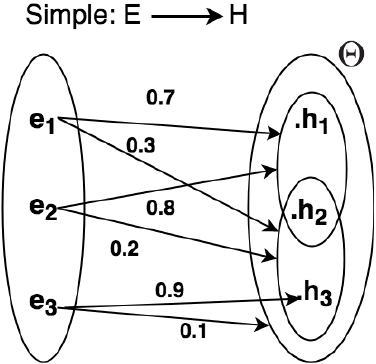
Figure 4. Graph for representing uncertain simple relations.